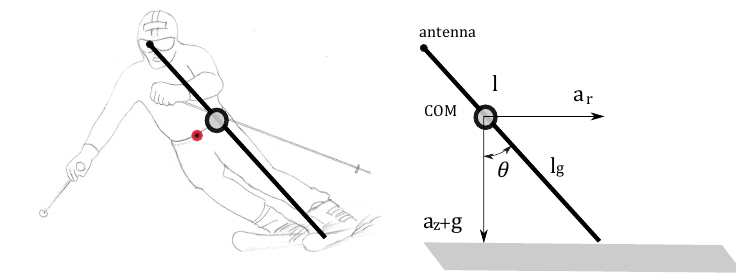
Figure 3. Skier modeled as the inverted pendulum. The red circle on the skier and the black circle on the model denote the center of mass (COM) of the skier and COM of the model,